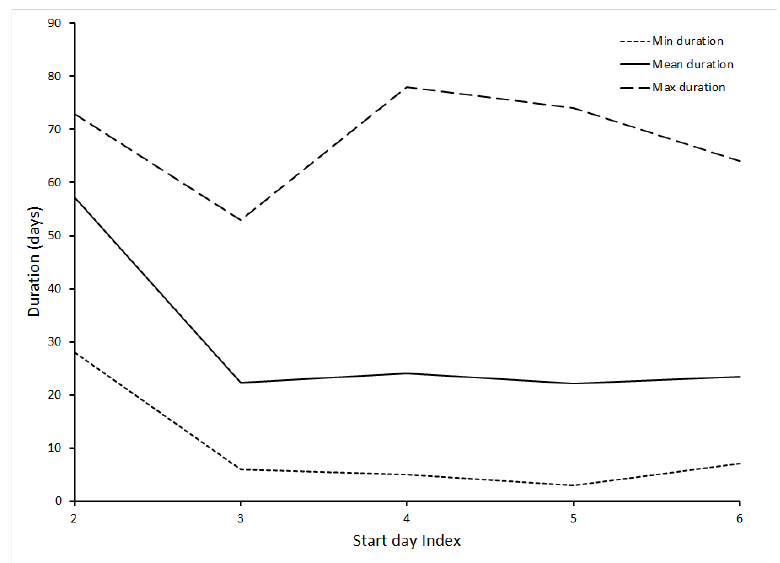
Figure 3. Final duration of fires based on start-day Haines Index value.